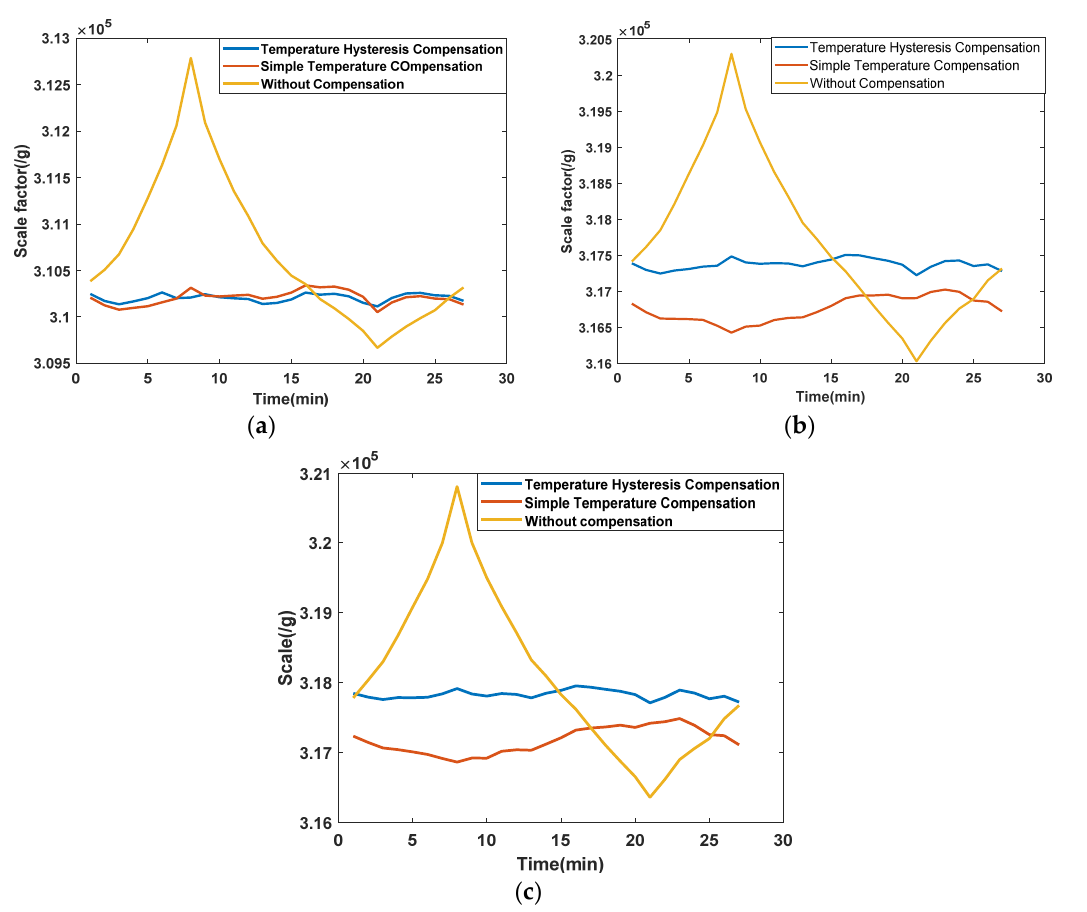
Figure 6. ( a ) is compensation of scale factor of JB-KT8 #1; ( b ) is Compensation of scale factor of JB-KT8 #2; ( c ) is Compensation of scale factor of JB-KT8 #3.